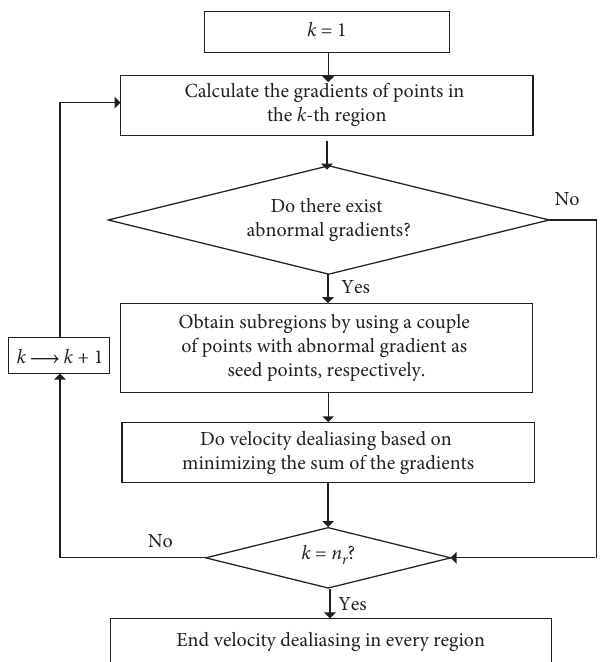
Figure 1: The flow chart of velocity dealiasing in every region in each elevation angle.